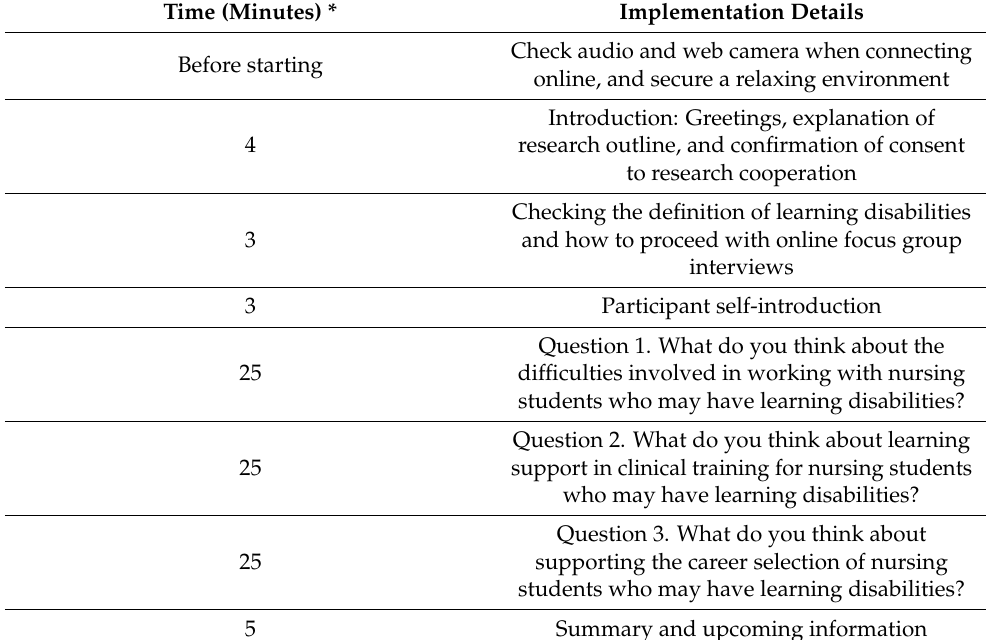
Table 1. Online focus group interview